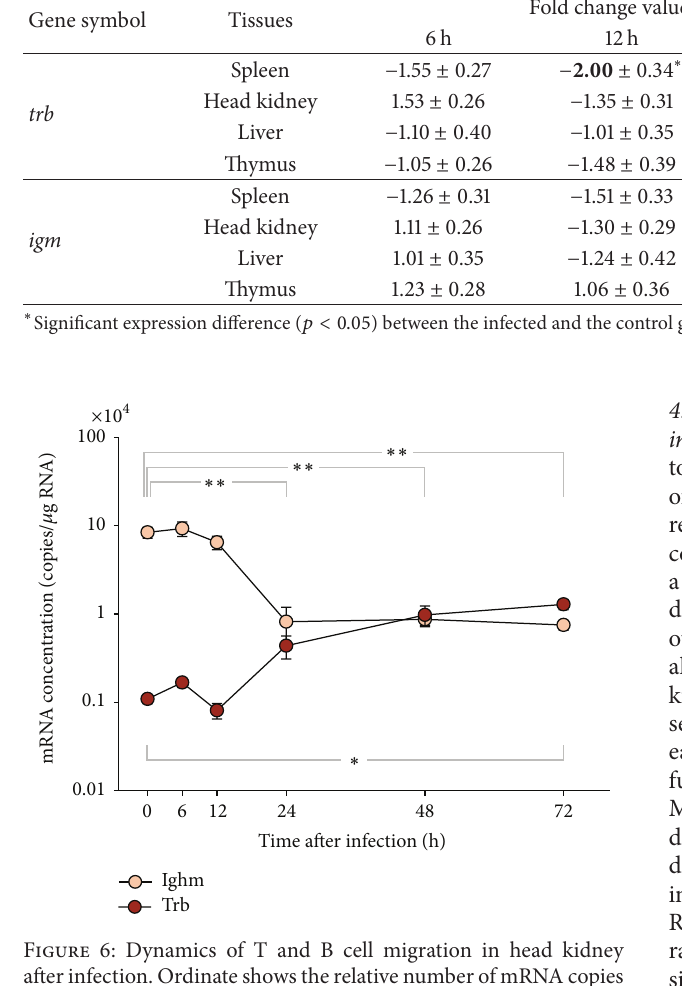
Table 4: Expression profiles of T and B cell marker genes in selected tissues of rainbow trout at different time points after infection. Gene symbol